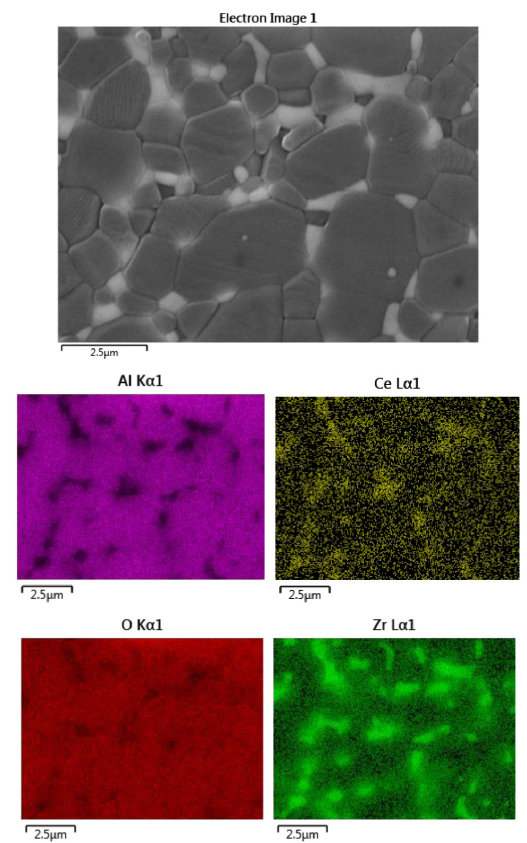
Figure 2. Microstructure of sintered monolithic-alumina ceramic, containing polygonal α-Al O grains. 2 3